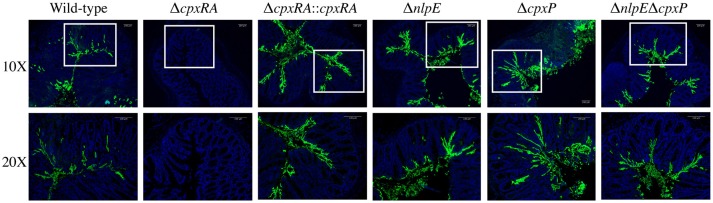
In vivo localization of wild-type and Cpx TCS mutant strains of Citrobacter rodentium in the intestine of C3H/HeJ mice. Localization of C. rodentium wild-type and Cpx TCS mutant strains in distal colon samples of day 9 infected C3H/HeJ mice. Sections stained with DAPI (blue) and anti-Citrobacter LPS (green). White boxes on 10X images denote the area of the 20X higher magnification image. Representative images shown from n = 3–4 biological replicates. Scale bars 100 μm.